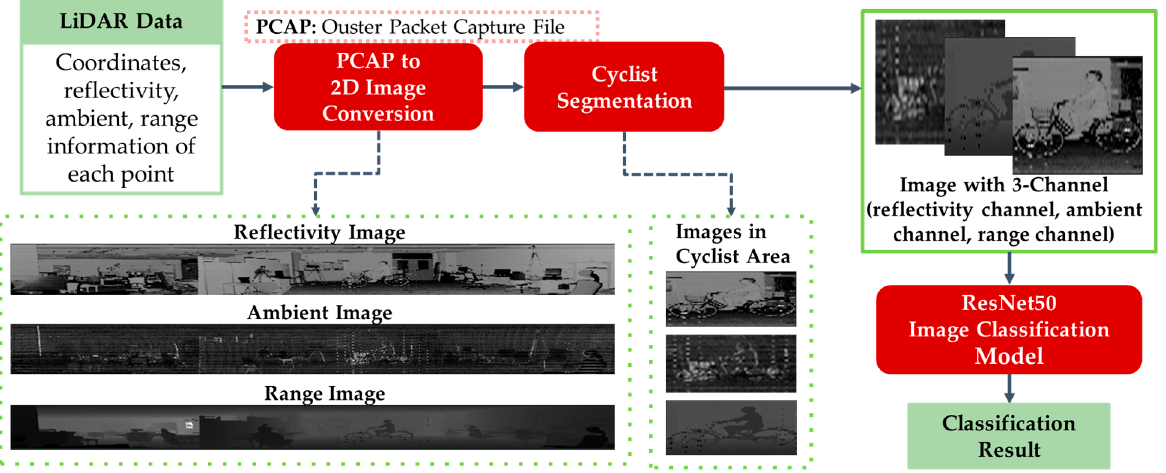
Figure 2. Flowchart of 2D image-based cyclist orientation estimation.